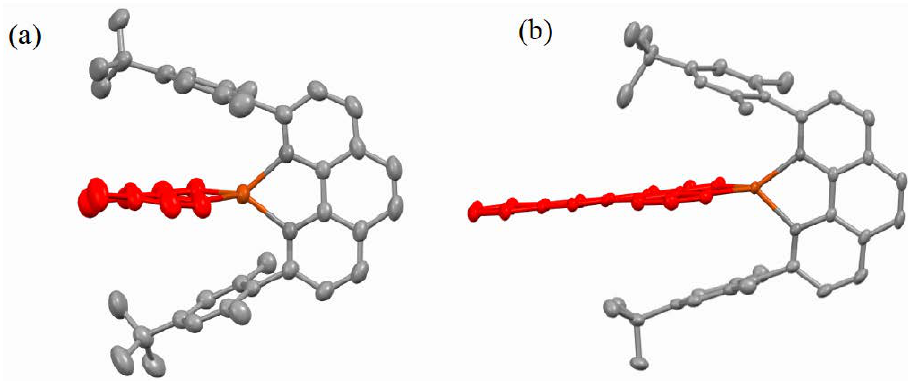
Figure 6. X-ray structures of ( a ) C6 and ( b ) C8 .